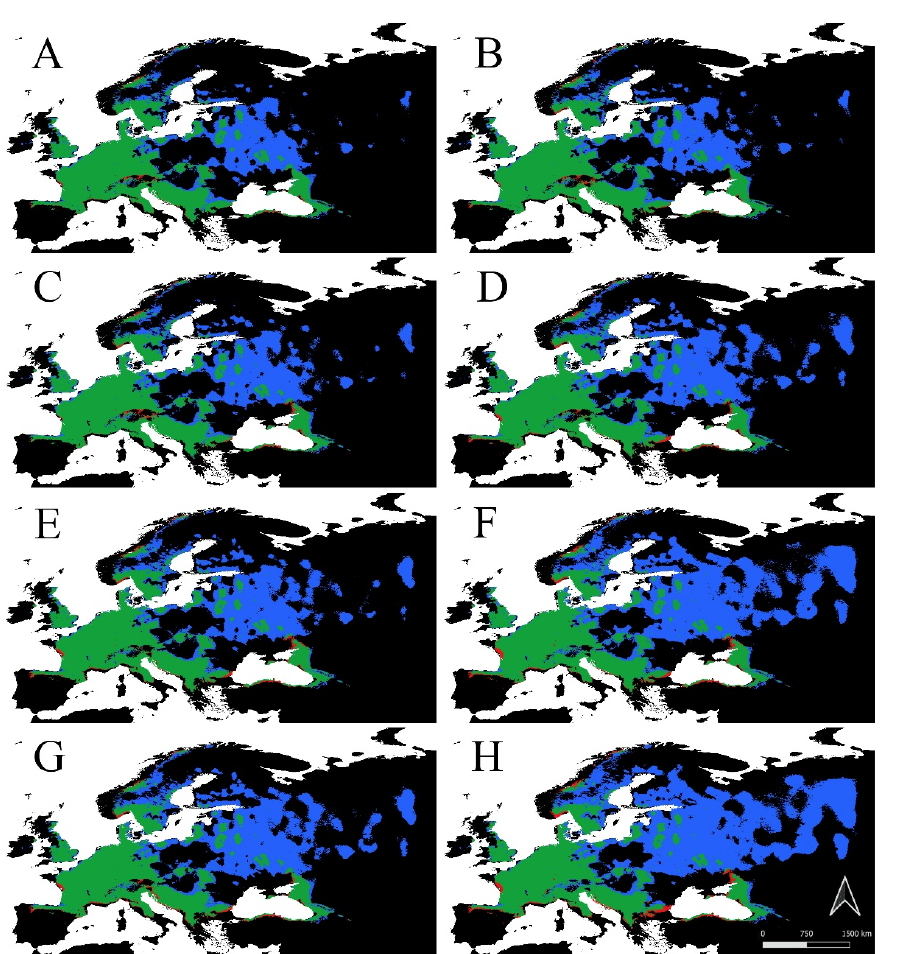
Figure 4. Maps of predicted shifts of Gnathotrichus materiarius climatic suitability, averaged across four GCMs in Europe for SSP126 ( A , E ) SSP245 ( B , F ) SSP370 ( C , G ) SSP585 ( D , H ) in two timelines: 2041– 2060 ( A – D ), 2061–2080 ( E – H ). Green—persistence, blue—range expansion, red—range contraction. Table 2. Predicted shifts of Gnathotrichus materiarius range size under analyzed SSP and timelines related to actual habitat